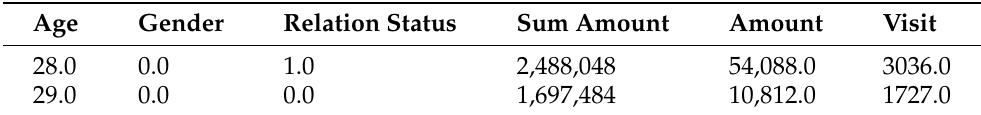
Table 8. Need based Package for Category D.